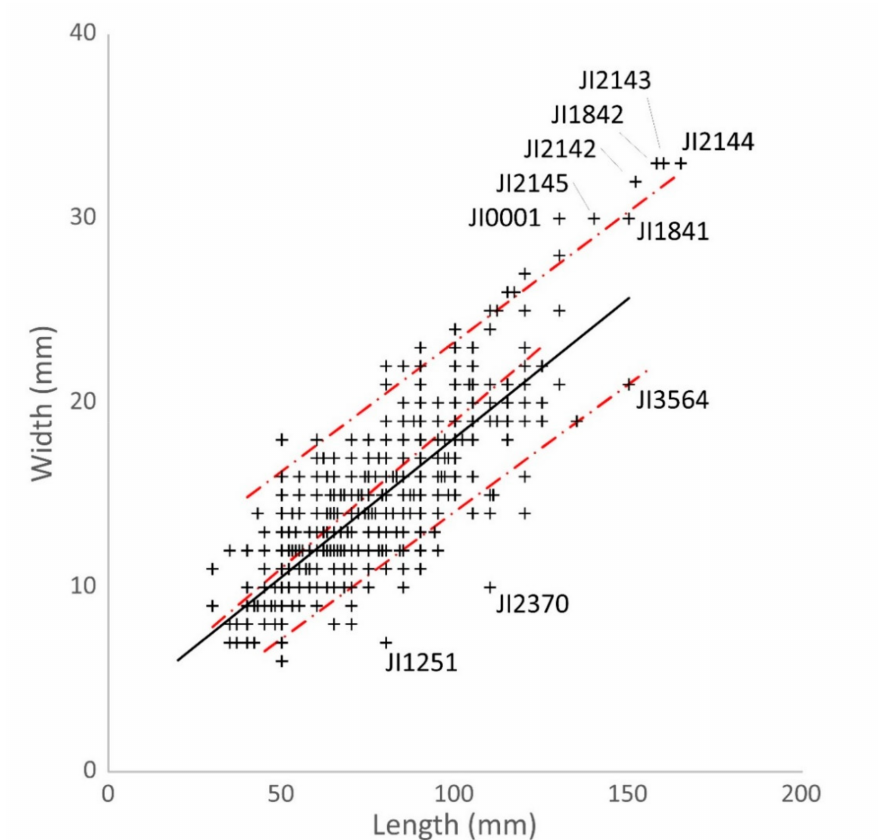
Figure 3. Pod length and width distribution for historic data (see also Supplementary Table S2). The solid black line is the regression for these data W = (0.15 ± 0.003) L + (3.02 ± 0.25). The dashed red lines are the three regression lines for the 2020 data from Figure 2c. The accession numbers for pods outside the upper and lower ranges of the 2020 data set are indicated.